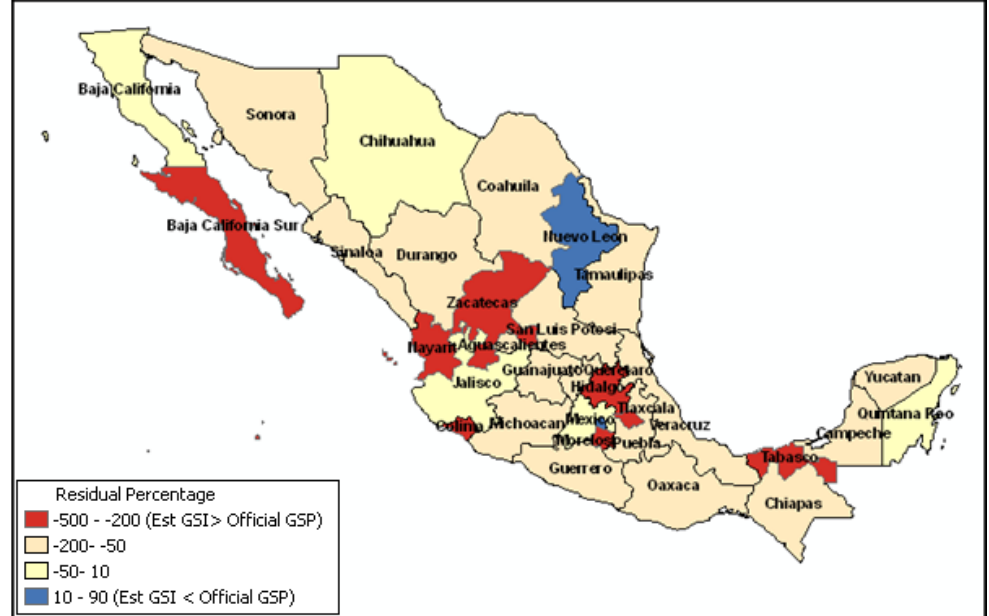
Figure 14. Map of the Percentage Residual Gross State Product by Mexican state